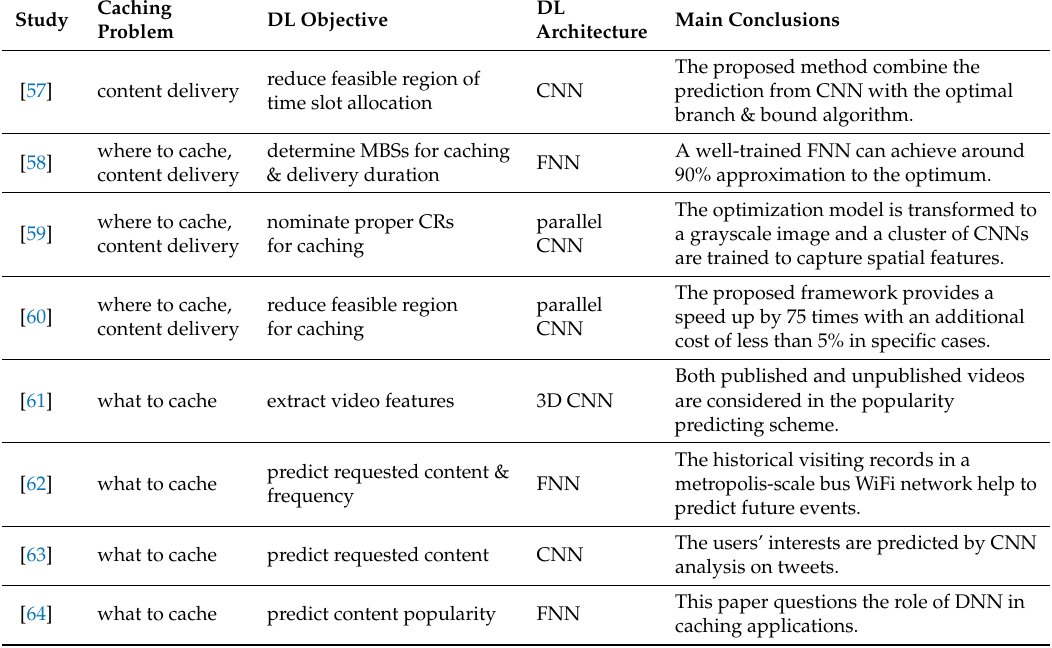
Table 3. Summary of fully-connected neural network (FNN) and convolutiuonal neural network (CNN) for data caching.